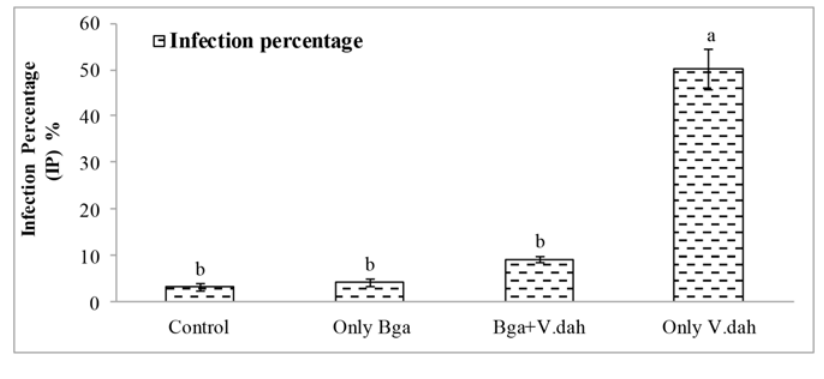
Figure 1. Symptomatic leaves percentage of tomato due to V.dah infection. Bars with dif- ferent letters indicate mean values significantly different at P<0.05 according to Tukey B test. Data are expressed as mean of 3 replicates ± SDs. IP = [(Symptomatic leaves / Total number of leaves) ×